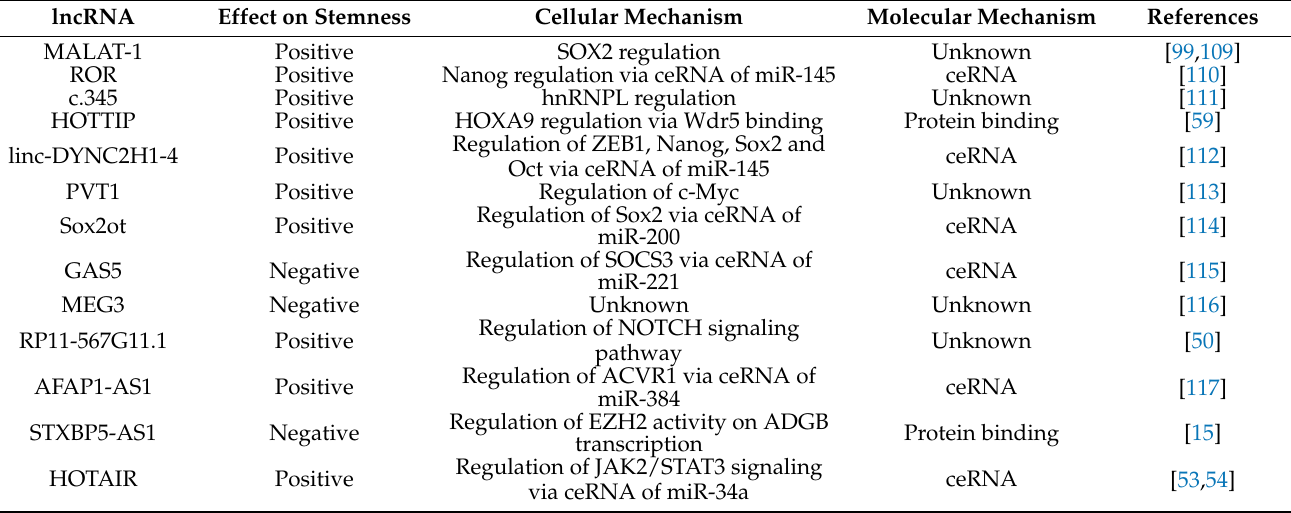
Table 2. lncRNAs involved in PDAC stem